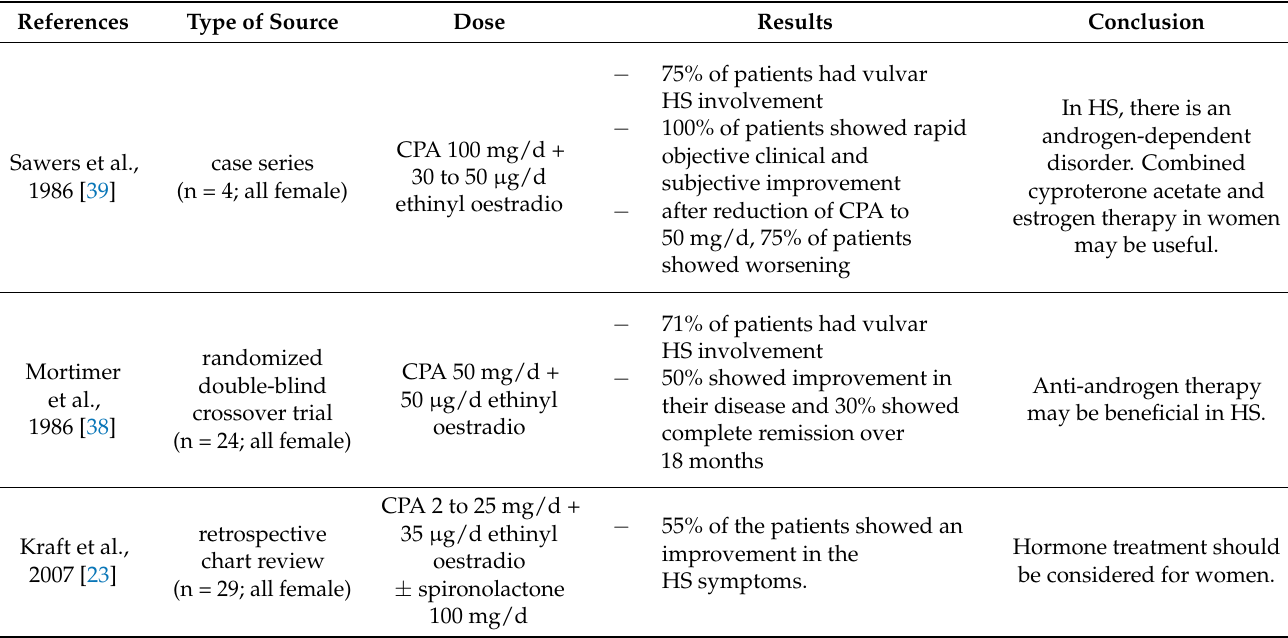
Table 5. Use of cyproterone acetate (CPA, competitive antagonist at the androgen receptor) in